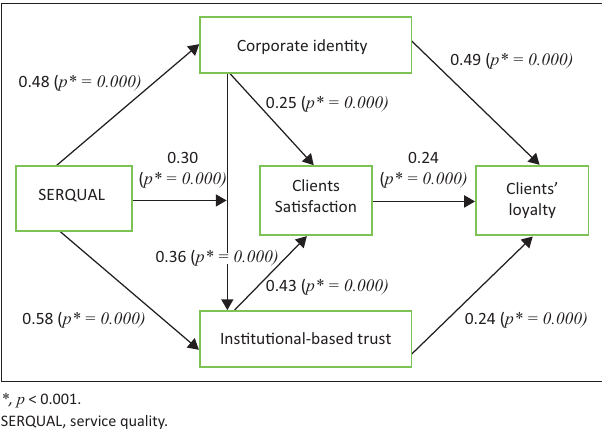
FIGURE 3: Structural regression estimates from AMOS